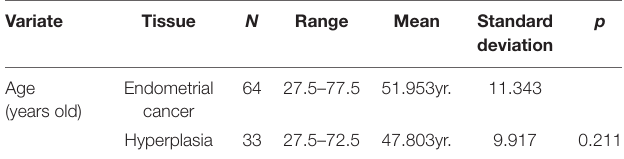
TABLE 1 | The characteristics of samples of